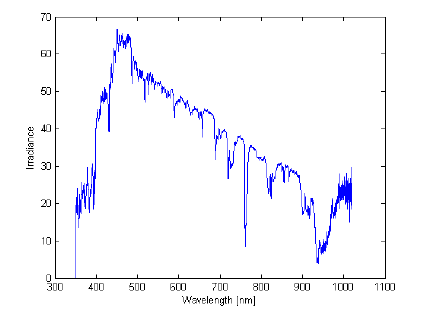
Figure 5. Irradiance spectrum for a single point. An example of the radiance of a tree top in one FPI-image, and the spectral irradiance measurement by USB2000+ during the exposure are shown in Figure 6. The derived at-sensor reflectance in Figure 6c is consistent with expected canopy reflectance. Reflectance of band 29 centered at 764 nm was distorted; this peak is visible also in individual irradiance spectrum measurement (Figure 6b) and similar for the all the collected images. Eliminating this observation provides consistent reflectance signature.